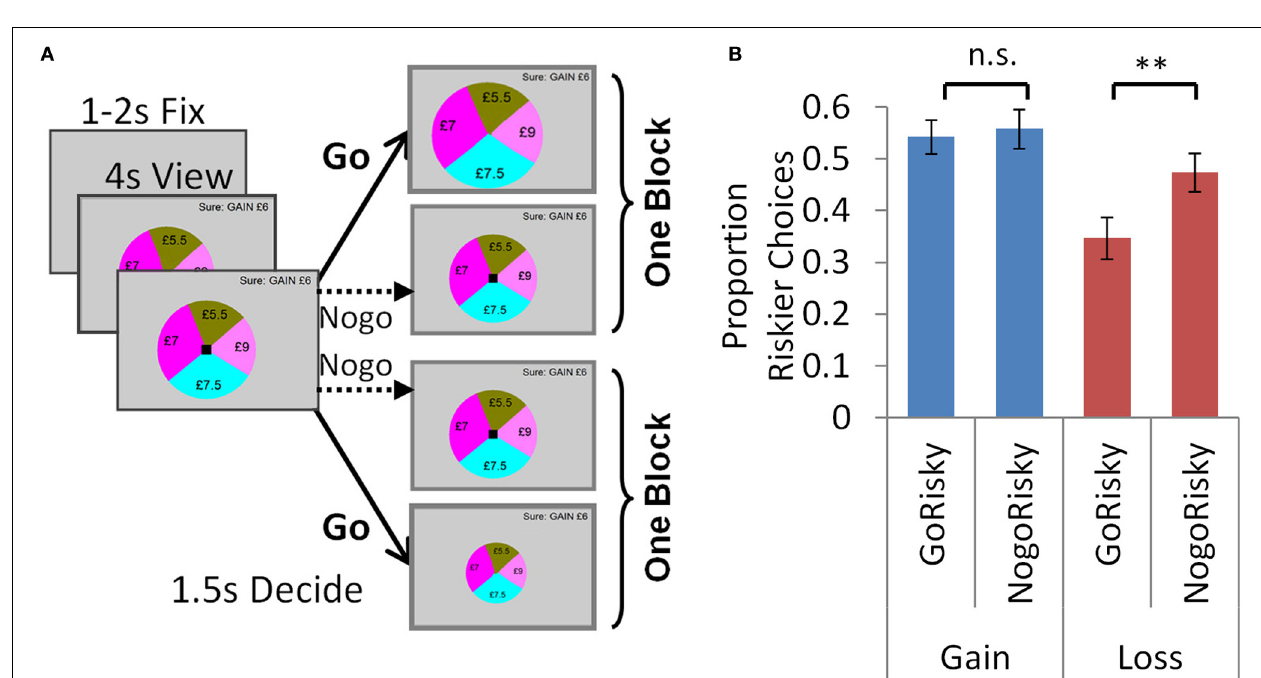
accept/reject task was seen in the three contexts (A) across subjects and (B–D) within individuals. (E) The perturbation by valence emerged within the setting with both gain and loss trials. Error bars show s.e.m. ∗∗ p < 0 . 005.